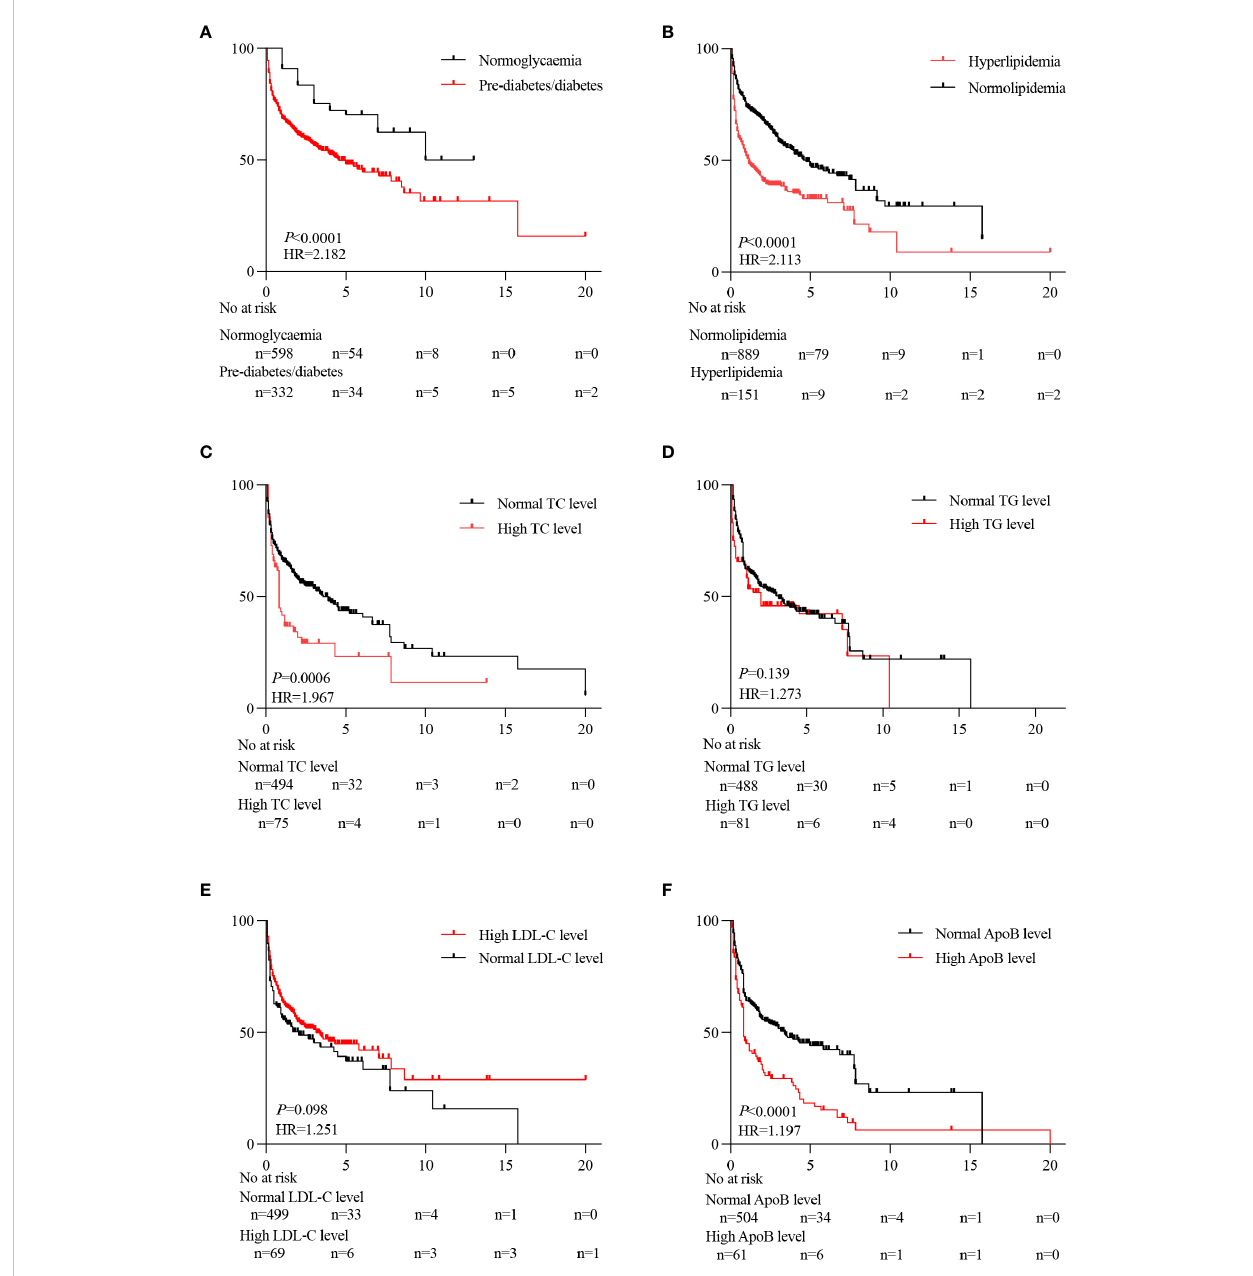
FIGURE 4 Effect of metabolic risk factors on the prognosis of PLC patients. Prognostic differences between pre-diabetes/diabetes and normoglycemia (A) . Prognostic differences between hyperlipidemia and normolipidemia (B) . Prognostic differences between normal TC level and high TC level (C) . Prognostic differences between normal TG level and high TG level (D) . Prognostic differences between normal LDL-C levels and high LDL-C levels (E) . Prognostic differences between normal ApoB level and high ApoB level (F)